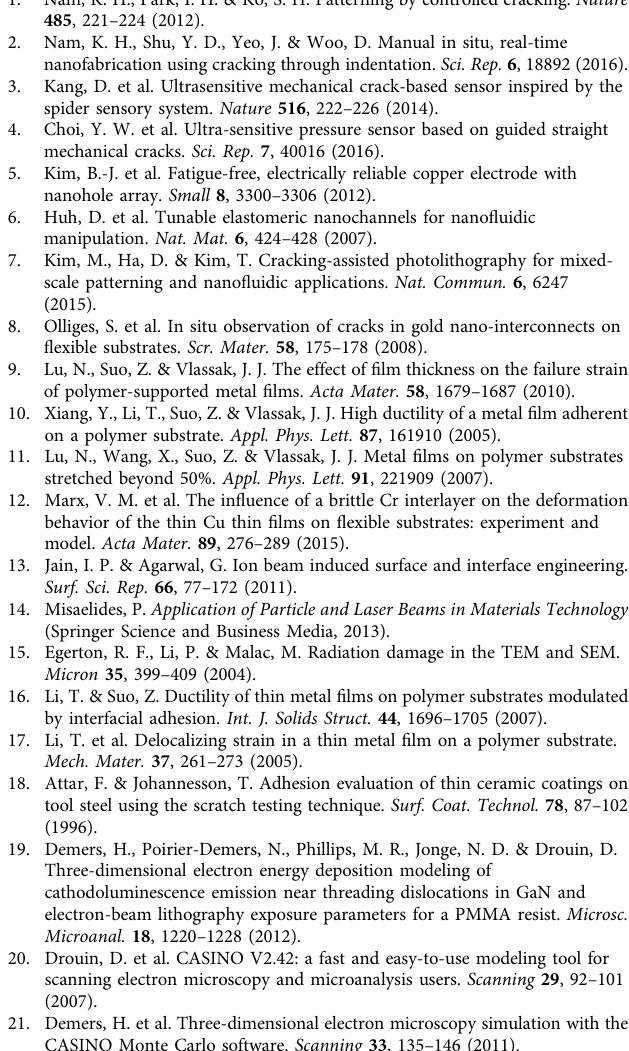
Fabrication of OLED . The top-emitting OLED has the following structure: PI/ 100 nm Cu/10 nm 1, 4, 5, 8, 9, 11-hexaazatriphenylene hexacarbonitrile (HAT- CN)/40nm N,N ’ -bis(naphthalene-1-yl)-N,N ’ -bis(phenyl)benzidine (NPB)/20nm 4,4 ’ -N,N ’ -dicarbazolebiphenyl (CBP) doped with 3 wt% fac -tris(2-phenylpyridine)